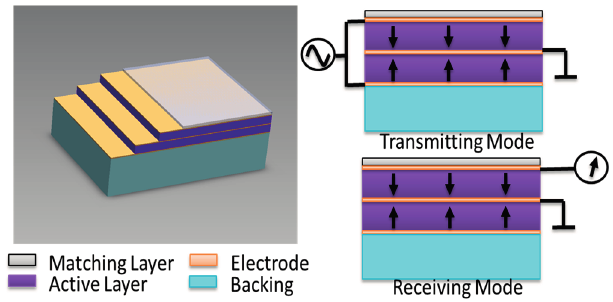
Figure 4. Schematic view of a dual-layer, dual-frequency transducer ( left ) and its operation for transmitting and receiving ( right ). When transmitting, both active layers are electrically connected in parallel and are excited by the same signal, effectively behaving as a single, active element at f 0 . When receiving, the front layer records the majority of the signal with a resonance at twice the transmission frequency (2 f 0 ) because the thickness of the active layer has effectively been halved. Figure reprinted with permission from